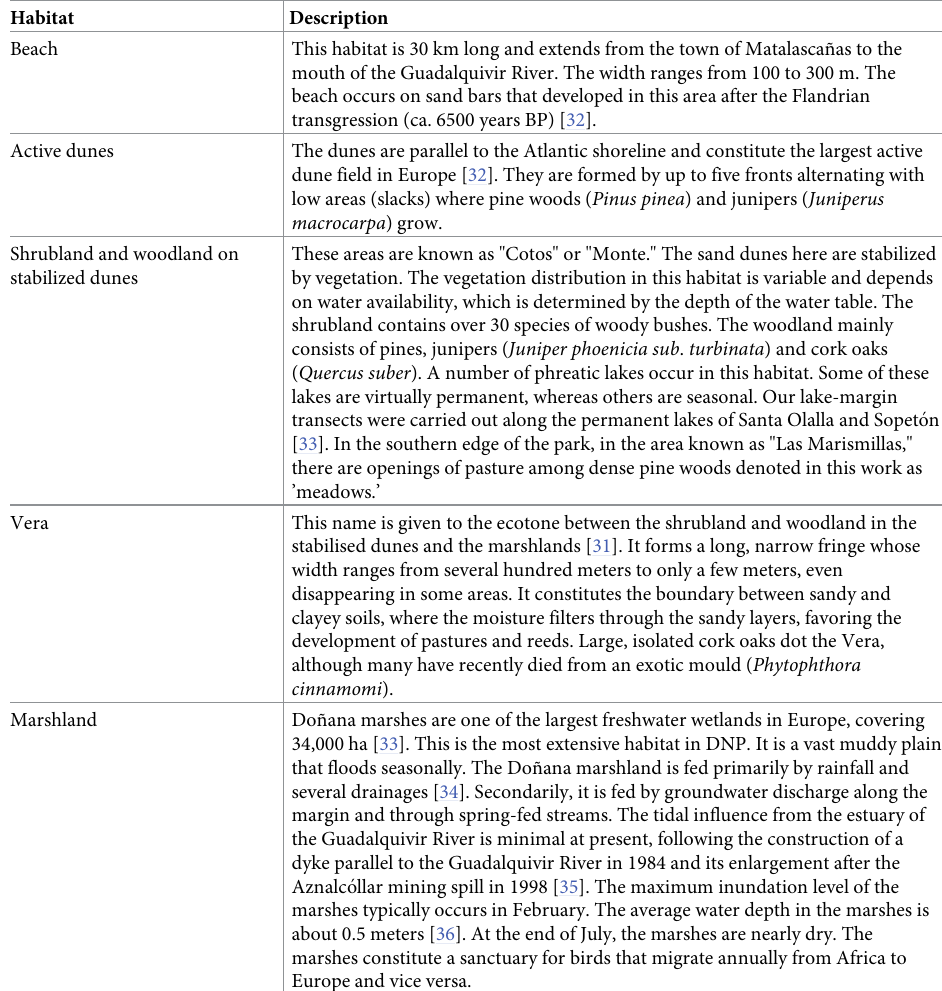
Table 1. Description of major habitats in Do ñ ana National